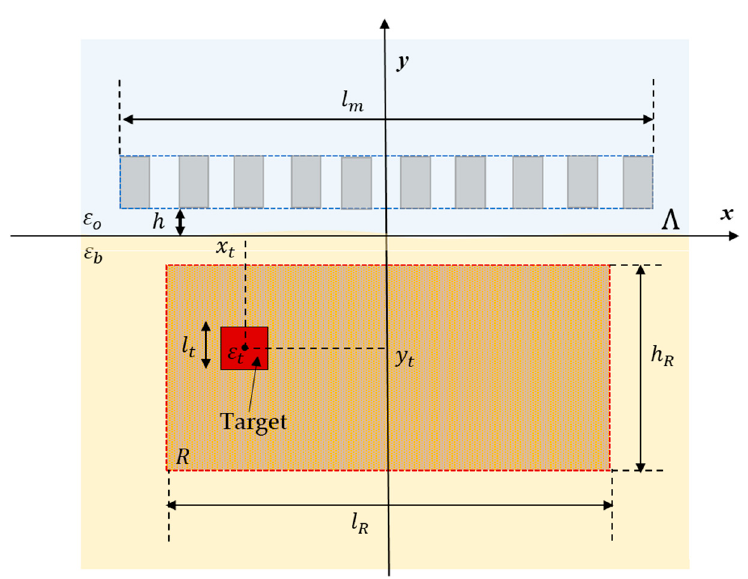
Figure 1. Geometry of the shallow subsurface scenario.